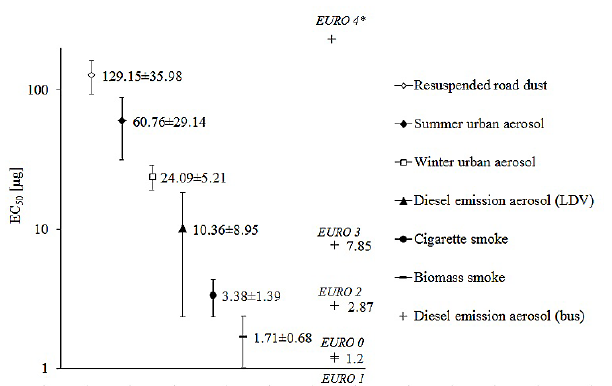
Fig. 1. Comparison of EC 50 values of aerosols of various types. Note that the lower the EC 50 value, the higher the ecotoxicity of the sample is. ∗ The diesel emission of EURO 4 engine was not ecotoxic.